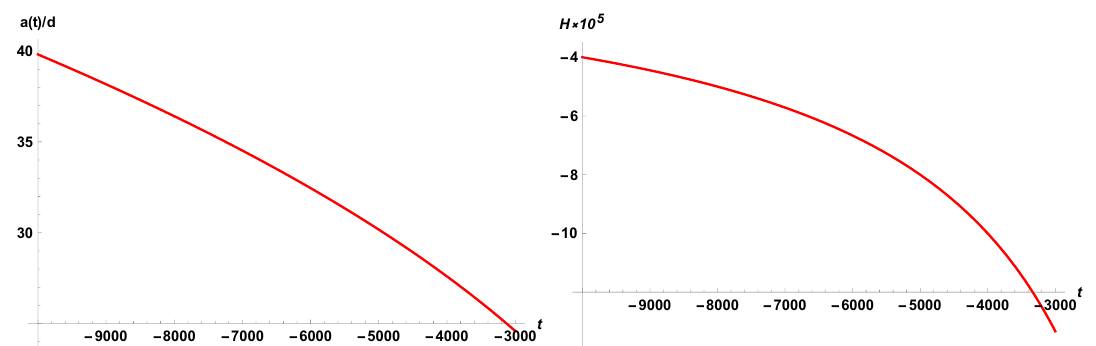
Figure 7 . The scale factor a ( t ) divided by d (left panel) and the Hubble parameter H ( t ) (right panel) in Jordan frame in the model with χ = 0 . 4 , n S = 0 . 967 (and µ = 1 . 0099 ).